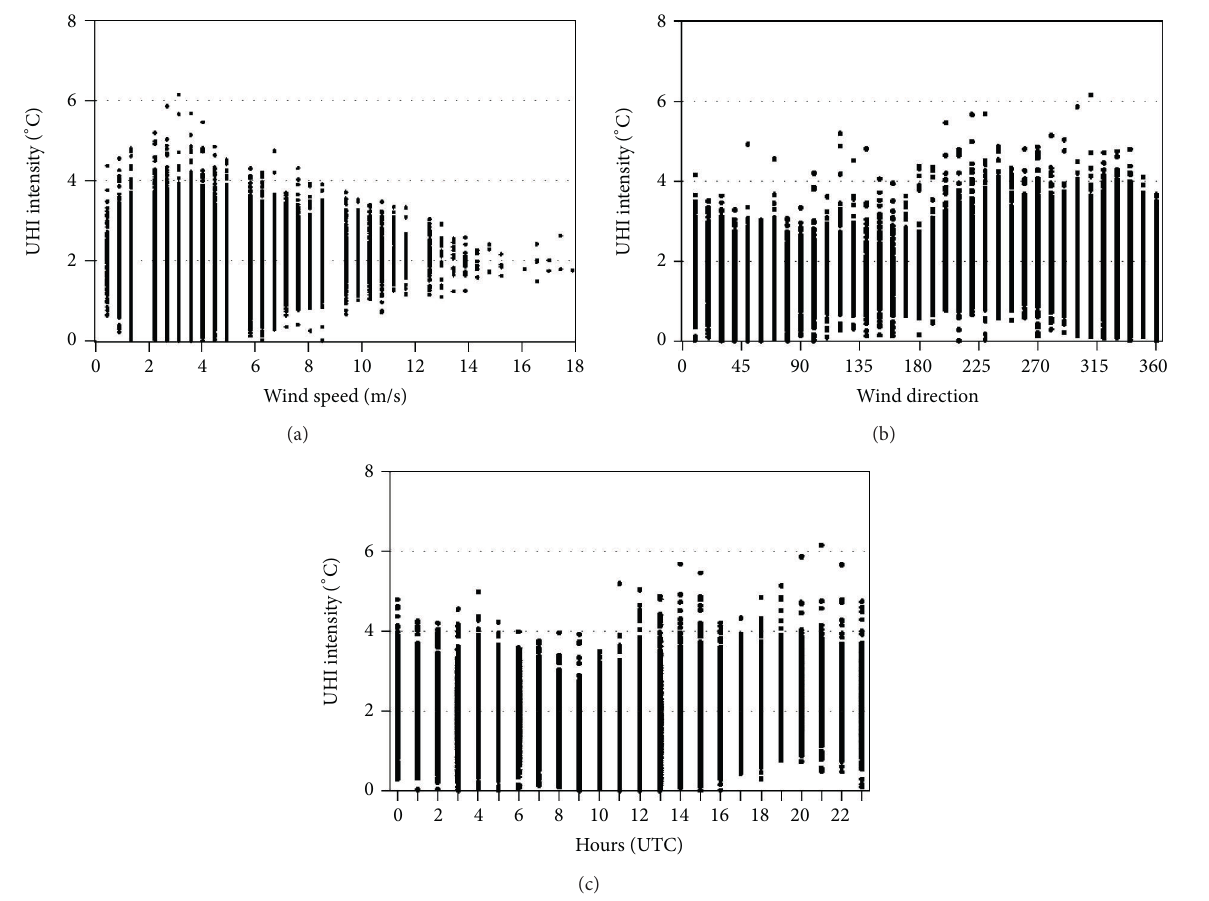
Figure 10: UHII versus wind speed (a), wind direction (b), and time (hours)